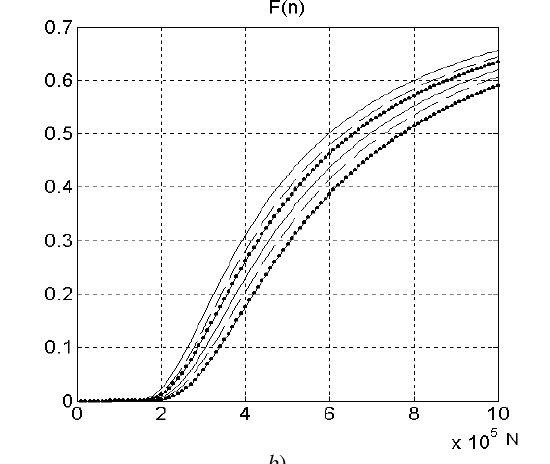
b ) Fig. 9. Densities ( а ) and distribution function ( b ) of cycle